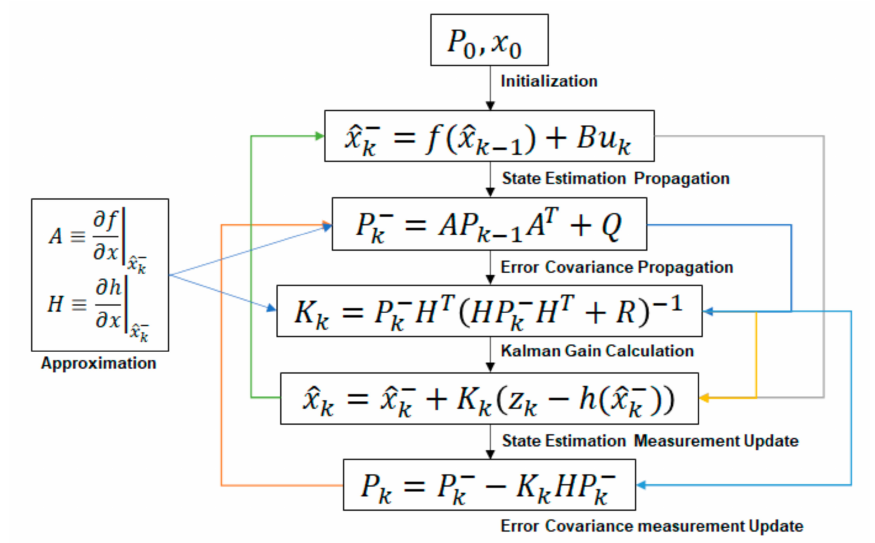
Figure 7. Computational procedure of the extended Kalman